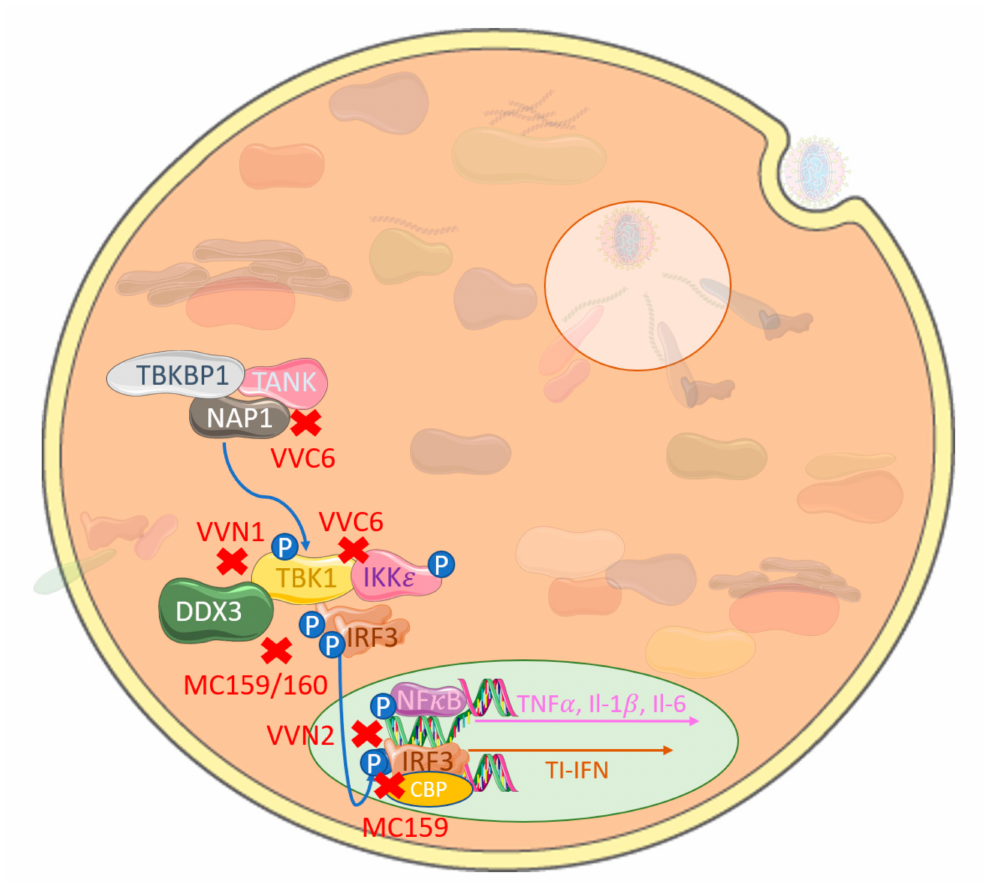
Figure 2. Poxviruses commonly inhibit interferon regulatory factor (IRF) signaling by targeting proximal activation complexes or IRFs directly. VACV-encoded C6 (VVC6) associates with multiple IRF3-activating adaptor proteins and kinase; TBKBP1, TANK, NAP1, TBK1 and IKKe